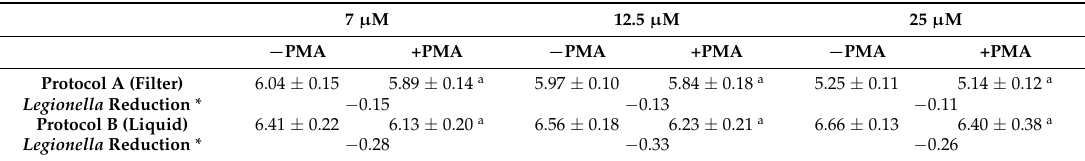
Table 1. Cytotoxic effect of different concentrations of propidium monoazide (PMA) on live Legionella pneumophila cells. 7 µ M Protocol A